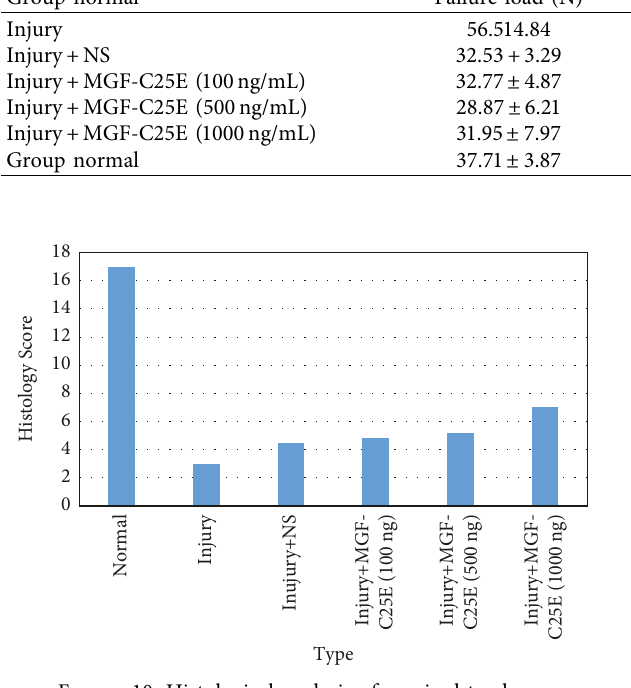
Figure 10: Histological analysis of repaired